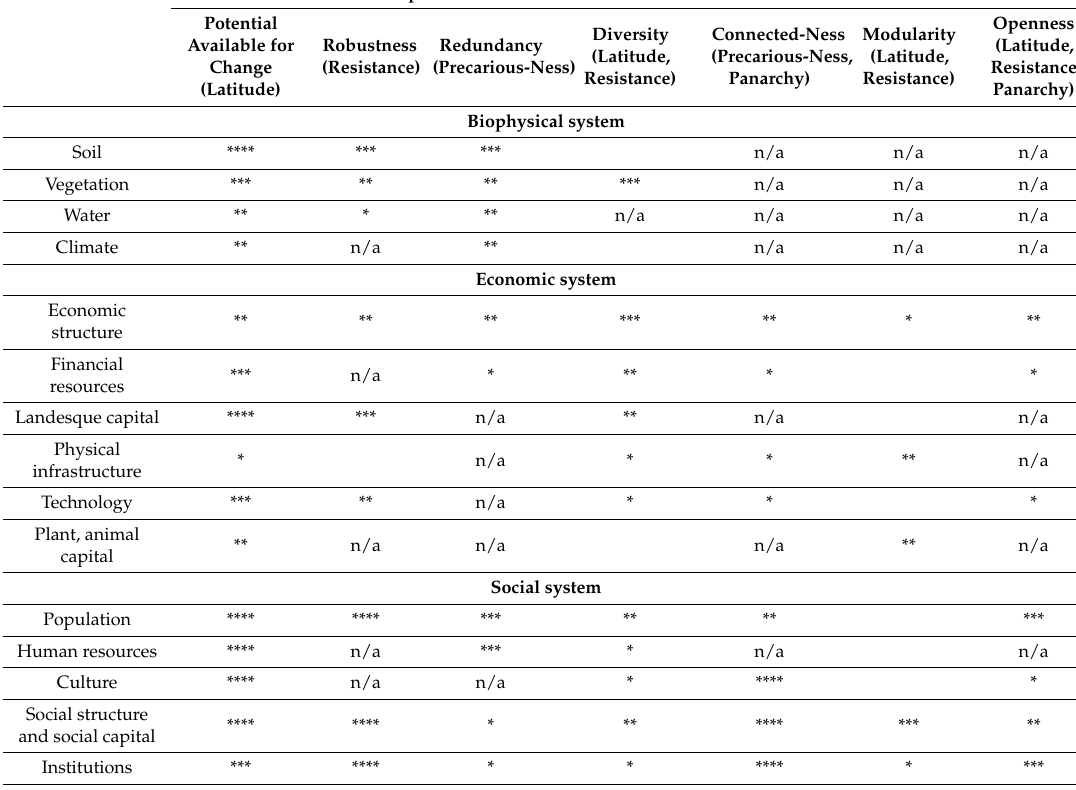
Table 9. Socioecological Fit of the Response Assemblage Assessment Matrix (SEFRAM) of the “Cereal modernization phase, 1950–1970”. Lower Level Properties (LLPs) and Associated Characteristics of the Basin of Attraction Openness Potential Modularity Diversity Connected-Ness (Latitude, Robustness Redundancy Available for (Latitude, (Latitude, (Precarious-Ness, Resistance, Change (Resistance) (Precarious-Ness) Panarchy) Resistance) Resistance) Panarchy) (Latitude) Biophysical